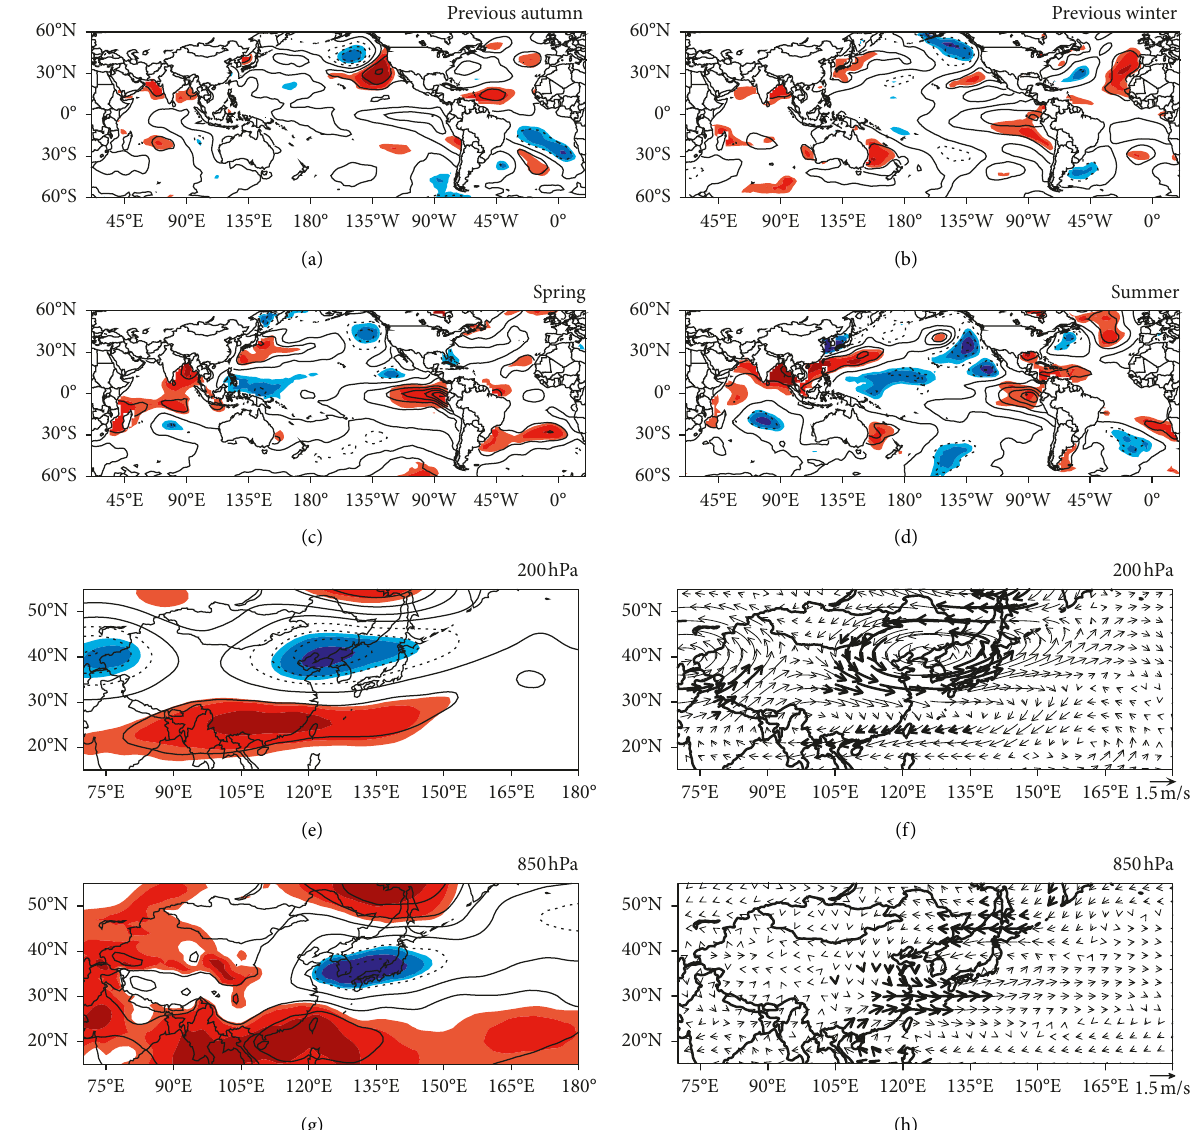
Figure 6: PC2-regressed SSTs in the previous autumn (a), previous winter (b), spring (c), and summer (d) during 1979–1999 (contour interval: 0.1). Previous autumn and winter denote the seasons before one year, which means the PC2-regressed SSTs in autumn and winter between during 1978–1998, respectively. PC2-regressed geopotential height and horizontal winds in boreal summer during 1979–1999 at 200hPa (e, f) and 850 hPa (g, h). Solid (dashed) contours denote positive (negative) anomalies, and thick solid lines denote zero. Red (blue) color shadings from light to dark indicate statistical significance at the 90%, 95%, and 99% levels. Contour intervals are 5 gpdm in (e) and 2 gpdm in (c). Thick vectors in (f) and (h) denote statistical significance at the 95% confidence